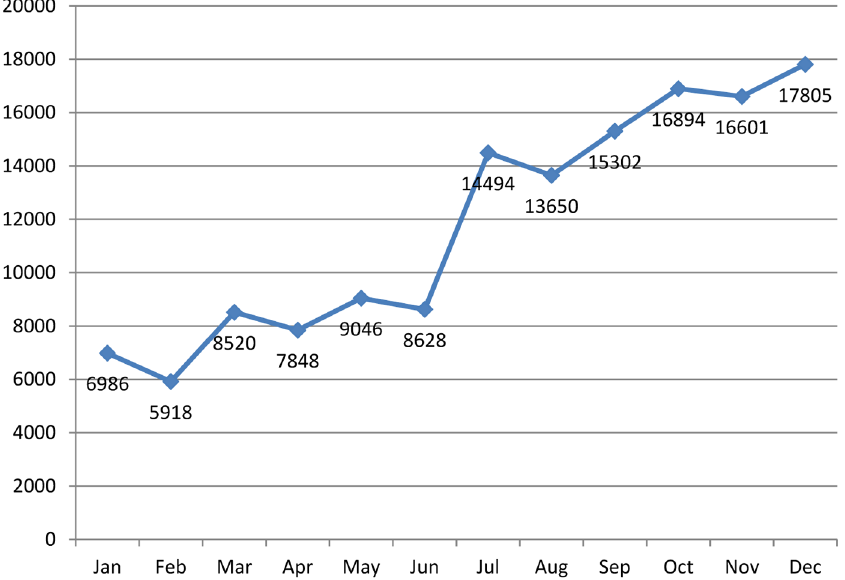
Figure 1. Number of article downloads per month in